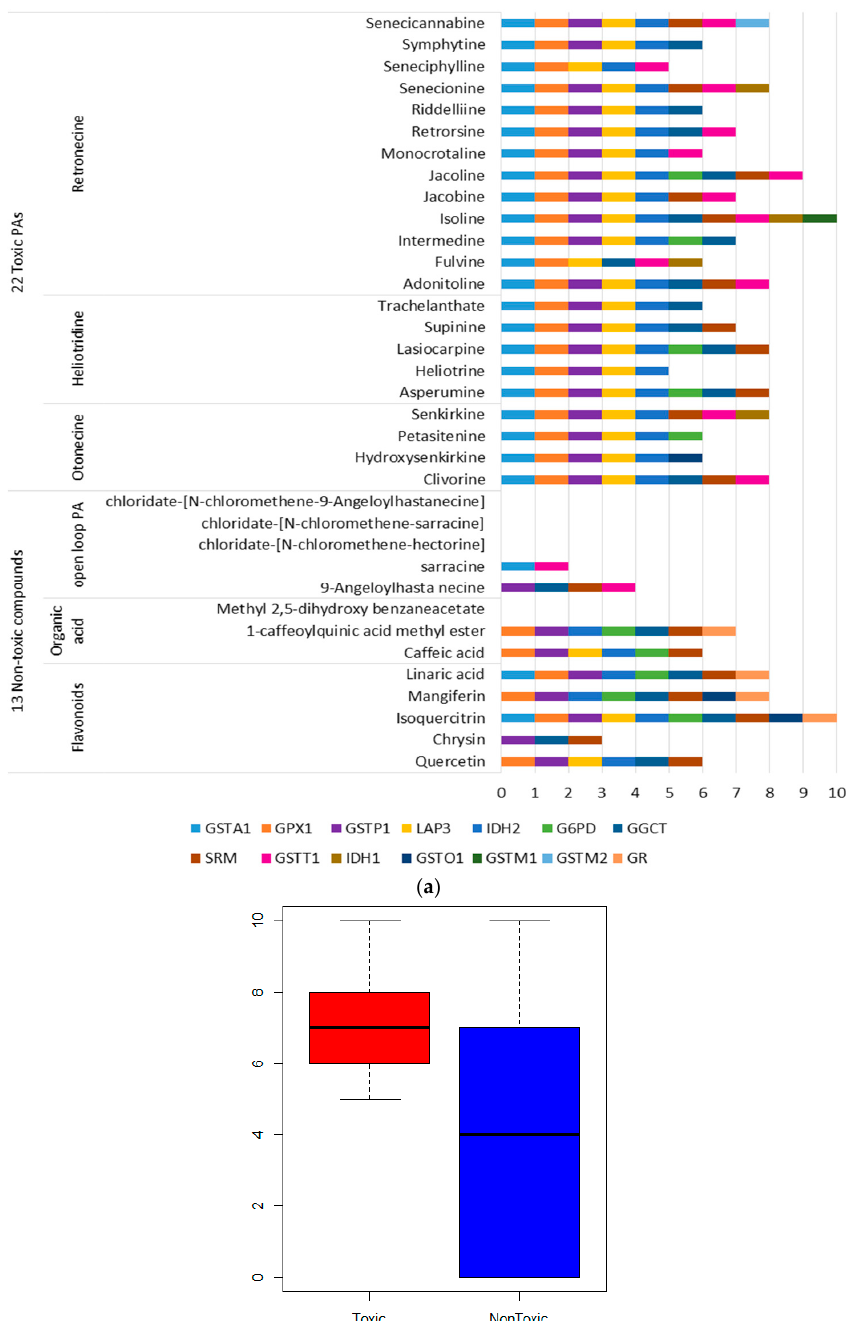
Figure 1. Potential protein targets of Pyrrolizidine Alkaloids (PAs): ( a ) Targets sets of toxic PAs and non-toxic compounds; ( b ) The distribution of the targets number.